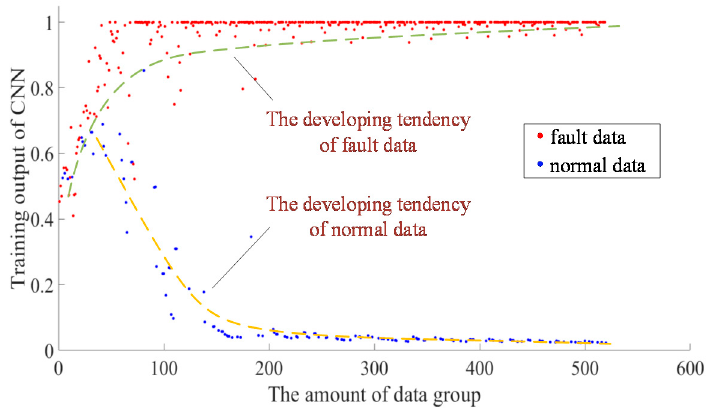
Figure 10. Fourier frequency spectrum of the arc current.